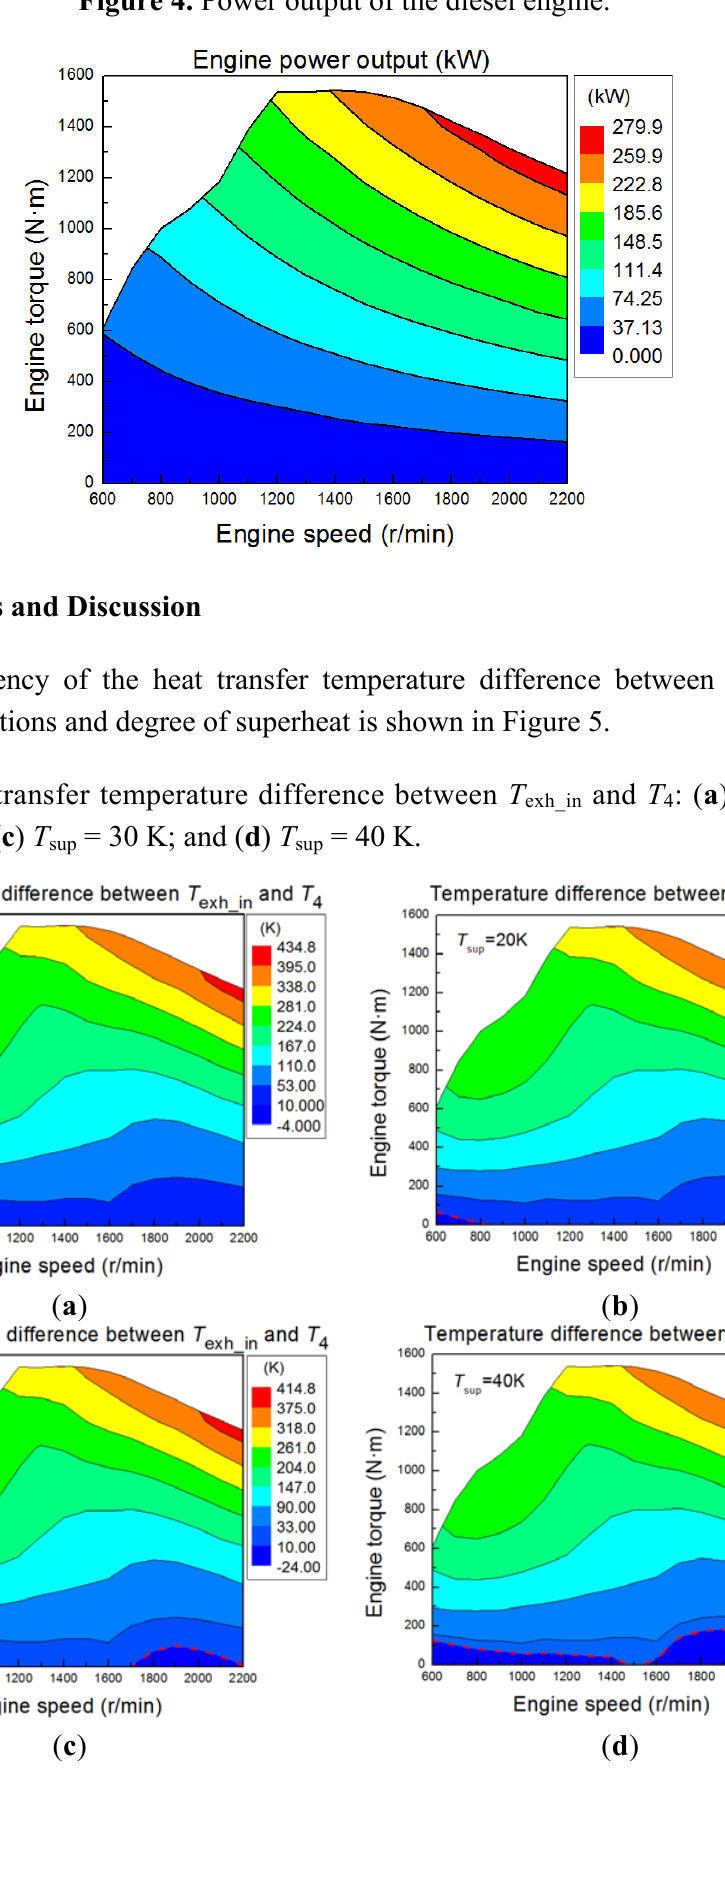
Figure 4. Power output of the diesel engine.